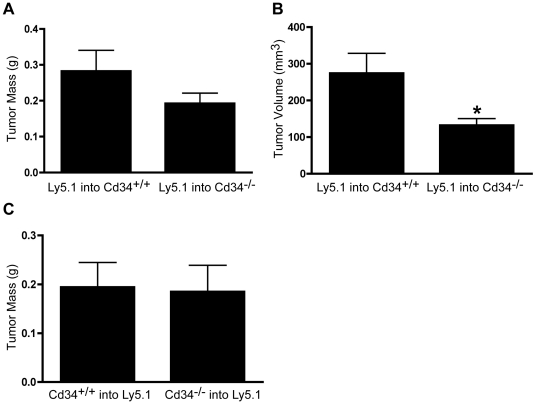
Reduced subcutaneous tumor size at day 14 correlates with loss of CD34 on non-hematopoietic cells.A, Average tumor mass and B, volume at day 14 in Cd34+/+ or Cd34−/− animals reconstituted with wildtype Ly5.1 bone marrow. (Pooled from two experiments, Cd34+/+ n = 13, Cd34−/− n = 14). C, Average tumor mass at day 14, in reciprocal reconstitutions of wildtype Ly5.1 animals with Cd34+/+ or Cd34−/− bone marrow (n = 9, *represents p<0.05; Error bars = SEM).